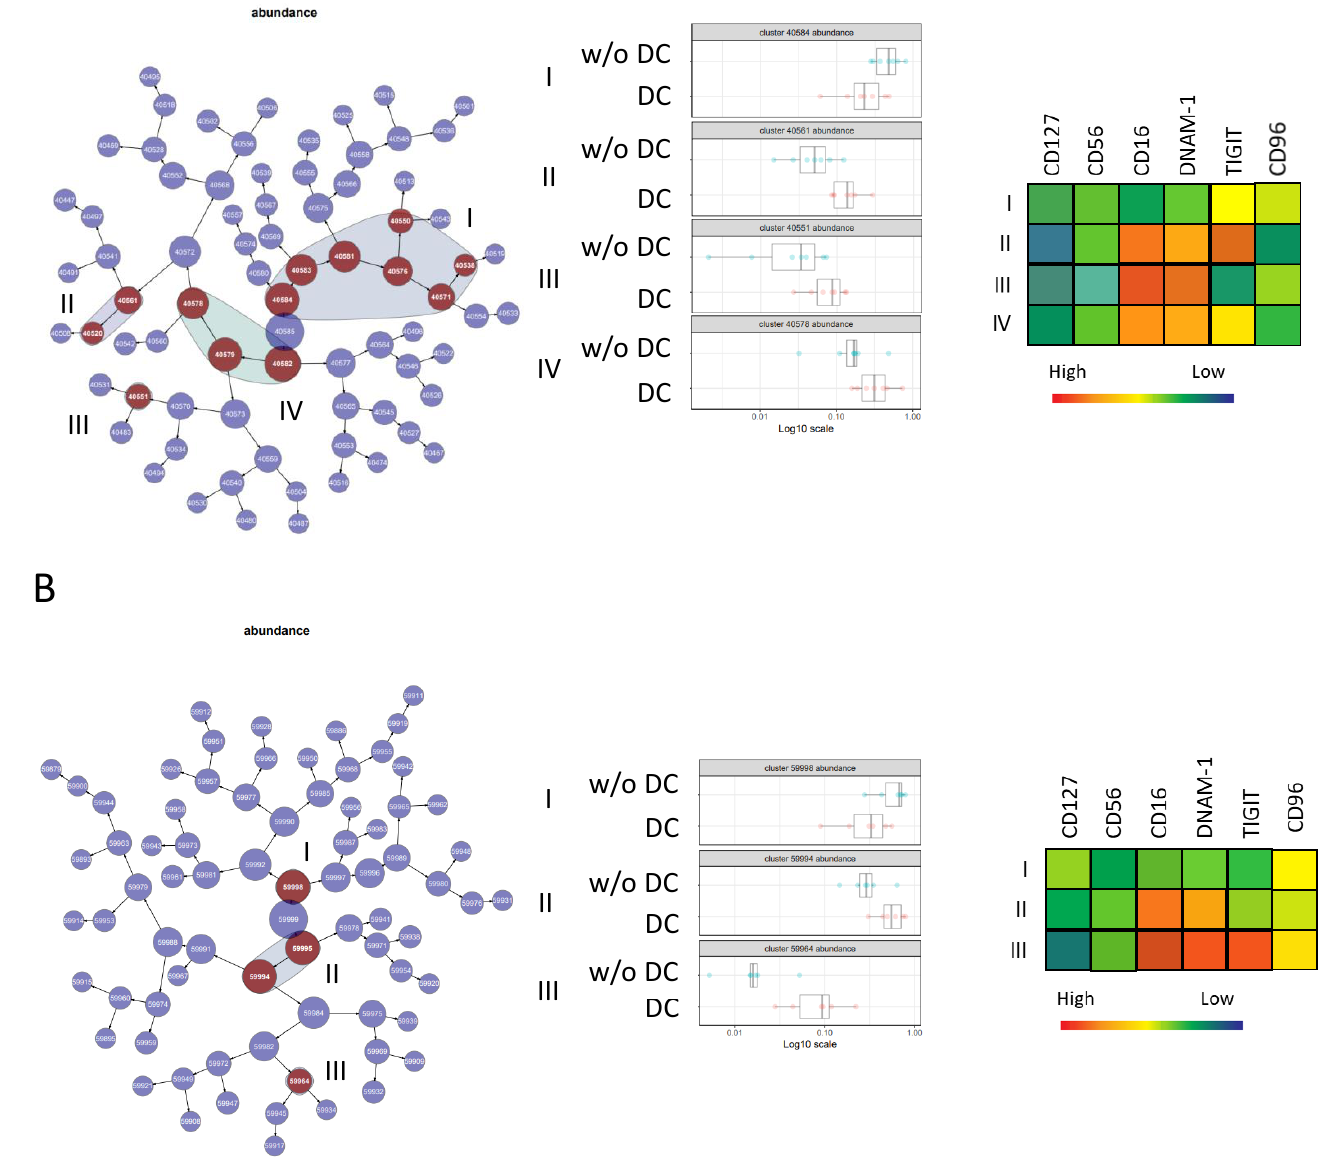
Figure 5. Comparison of natural killer (NK) subpopulations in DC patients and in patients w/oDC with citrus. A hierarchical clustering map of the CITRUS analysis comparing DC patients and w/oDC patients at D0 ( A ) and W12 ( B ). Clusters whose cell abundances are different between the two conditions are in dark red. Four groups of clusters are noted at D0 and three at W12. The cell abundance in the different clusters is represented on the left side with a heatmap presenting the phenotypes of these